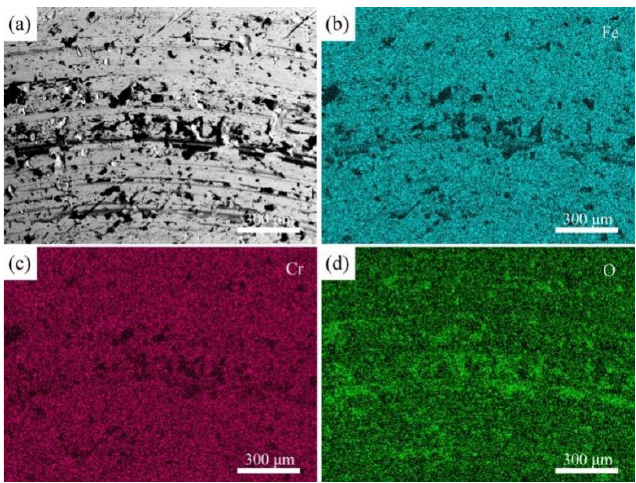
Figure 8. The mapping of elements of grinding crack of the Fe-Cr-B-C coating. ( a ) is SEM micrograph of grinding crack of the Fe-Cr-B-C coating, ( b − d ) is the distribution of Fe, Cr, O element,